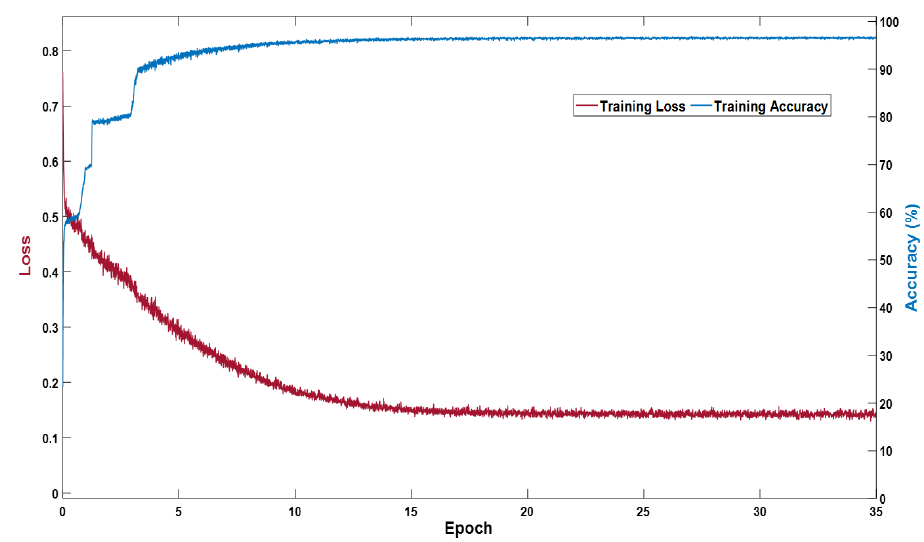
Figure 6. VSUL-Net training accuracy and loss curves for the DRIVE dataset.